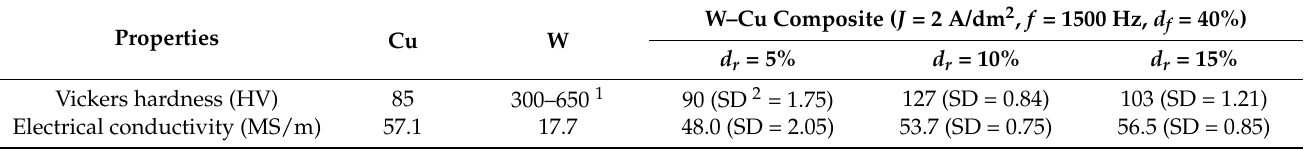
Table 2. The comparison of Vickers hardness and electrical conductivity of W–Cu composites under different reverse duty cycles: d r = 5%, d r = 10%, and d r =